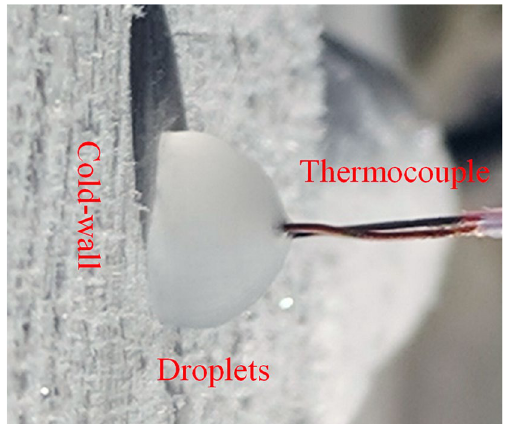
Figure 21. Icing of